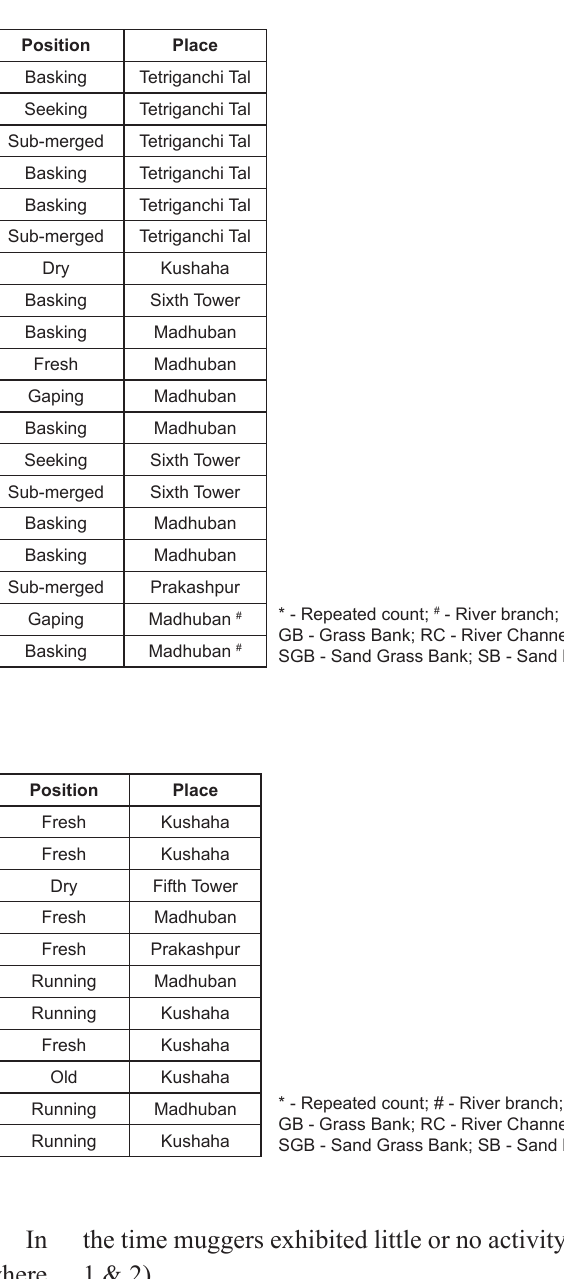
Table 1. The result of survey in winter